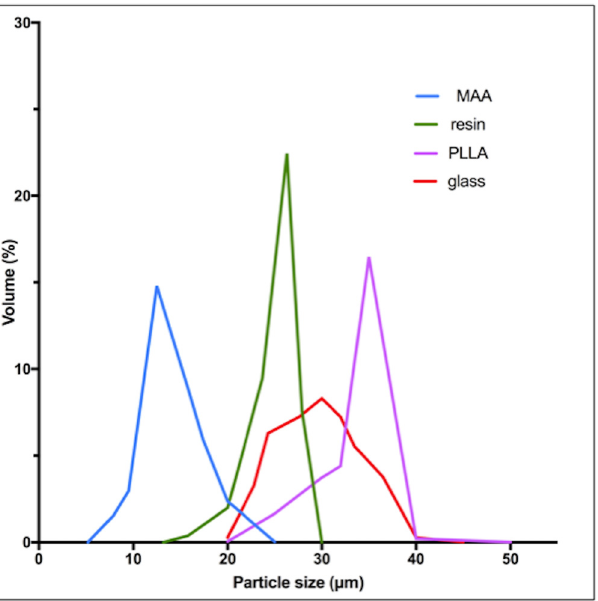
Figure 1. Particle size distribution for resin, glass, PLLA microspheres and MAA particles. Figure 1 was made by rescaling graphs derived from the analyses of Bakker et al. [30], Bult W. [31] and Gupta et al. using iron labeled glass microspheres [32].